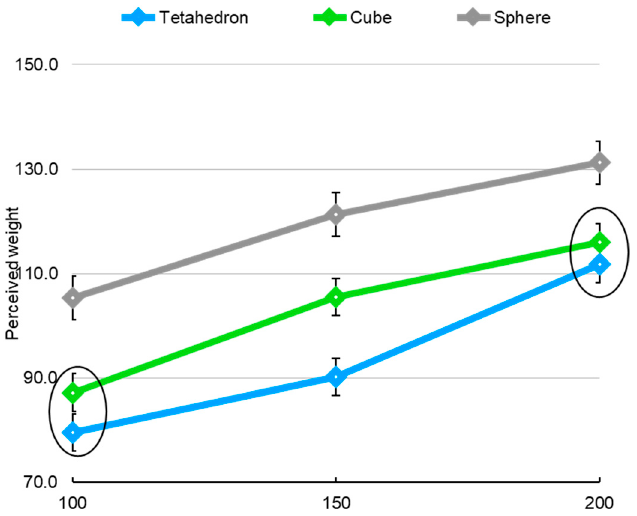
Figure 4. Interaction effects of weight and shape of objects on perceived weight (circles mean groups that did not differ statistically).